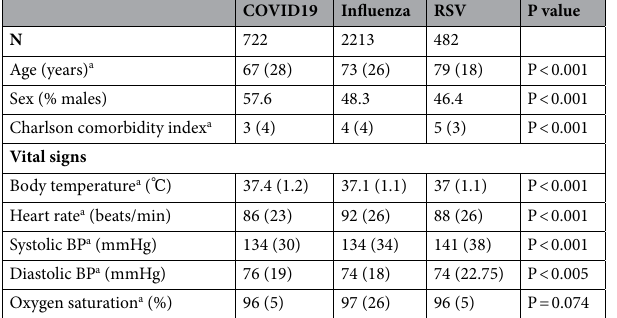
Table 1. Characteristics of patients presenting with viral infections. a Continuous variables are presented as medians and inter-quartile ranges. COVID-19 coronavirus disease 2019, RSV respiratory syncytial virus, BP blood pressure.